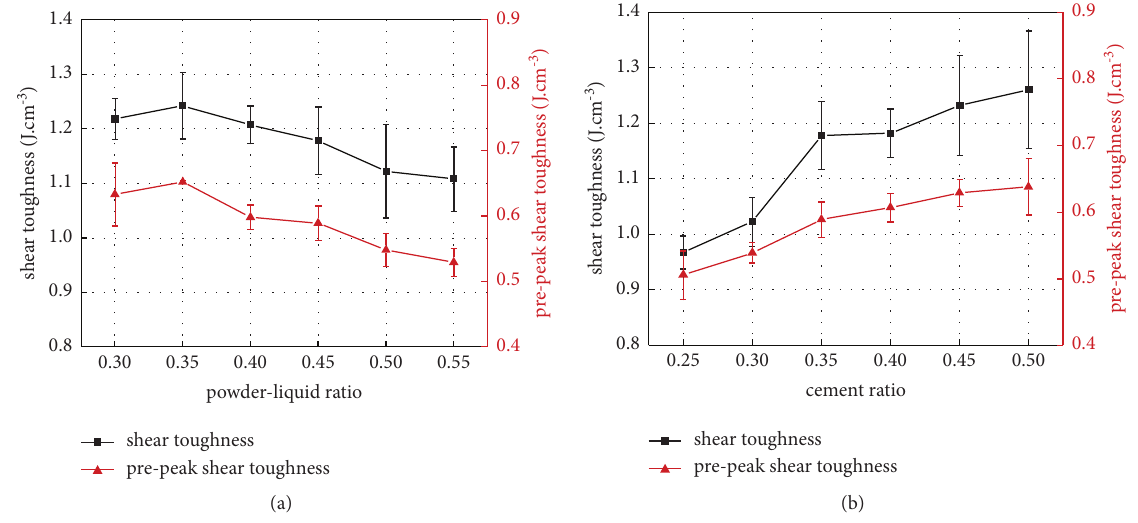
Figure 16: Change of shear energy consumption indexes of PCC with powder-liquid ratio and cement ratio: (a) powder-liquid ratio; (b) cement